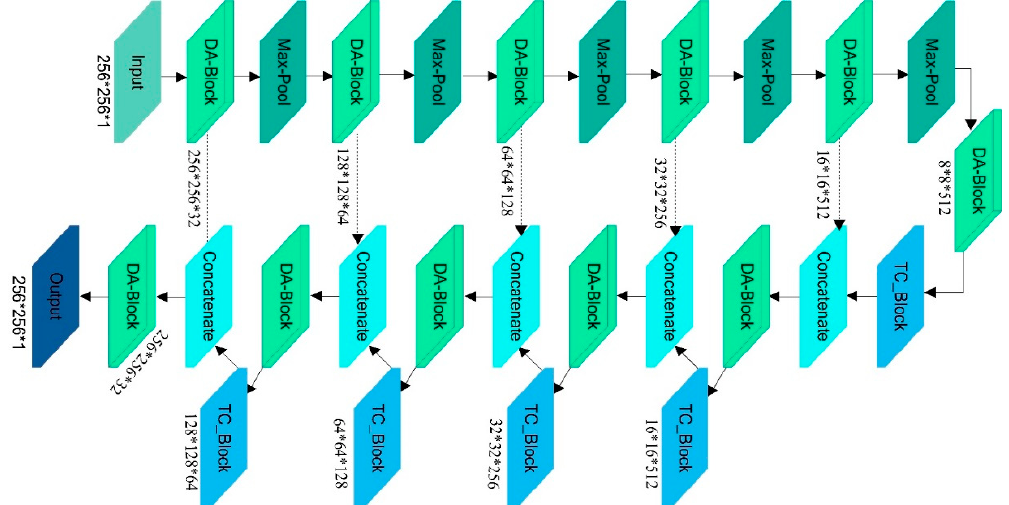
Figure 4. An improved U-Net architecture with DA, pooling, and transposed convolution blocks.